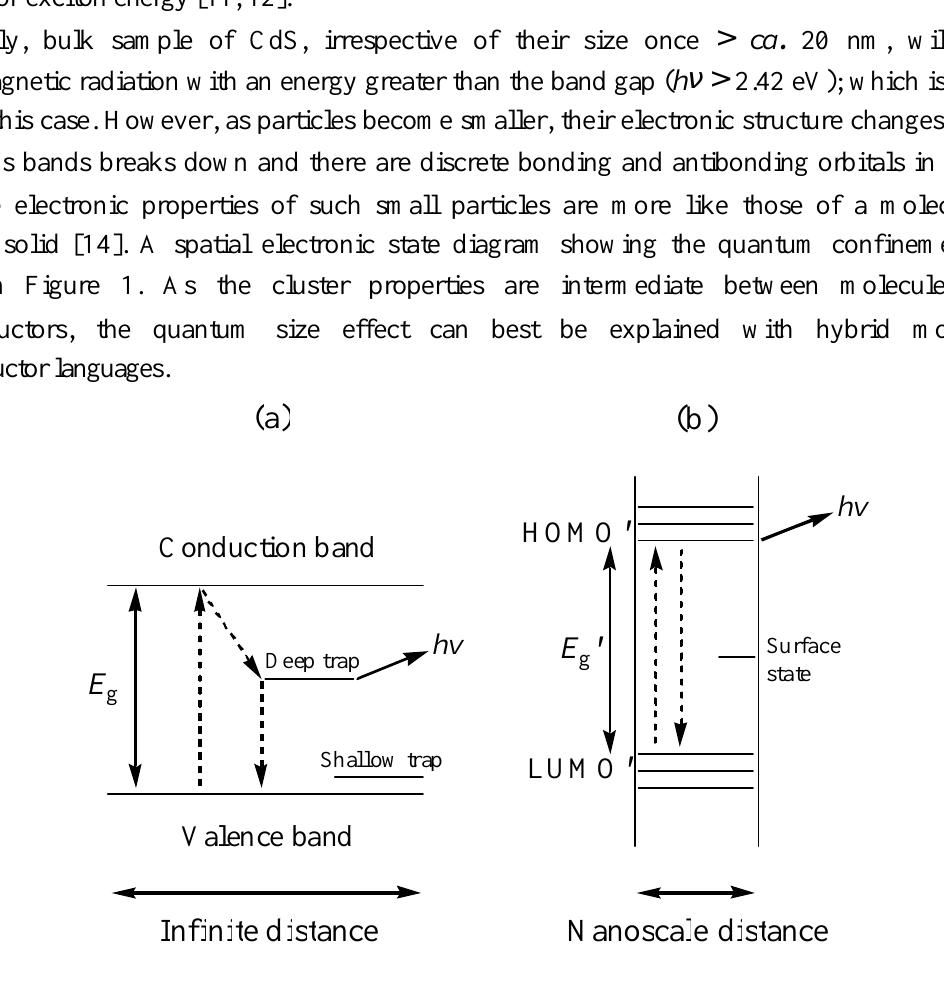
Figure 1: The spatial electronic state diagram showing the quantum confinement effect in bulk semiconductors (a) and nanoparticles